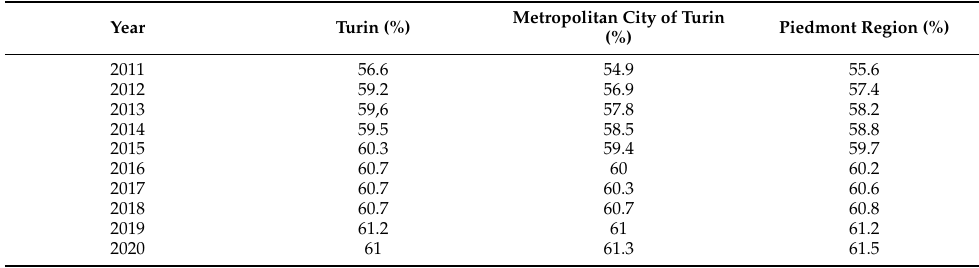
Table 8. Dependency ratio for the City of Turin, the Metropolitan City, and the Piedmont Region from 2011 to 2020